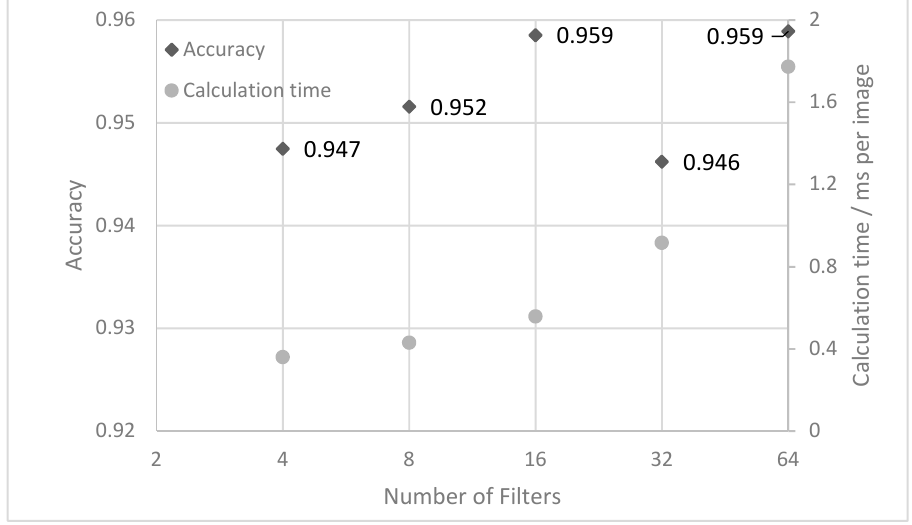
Figure 8. Test accuracy for the convolutional neural network as a function of the number of filters.